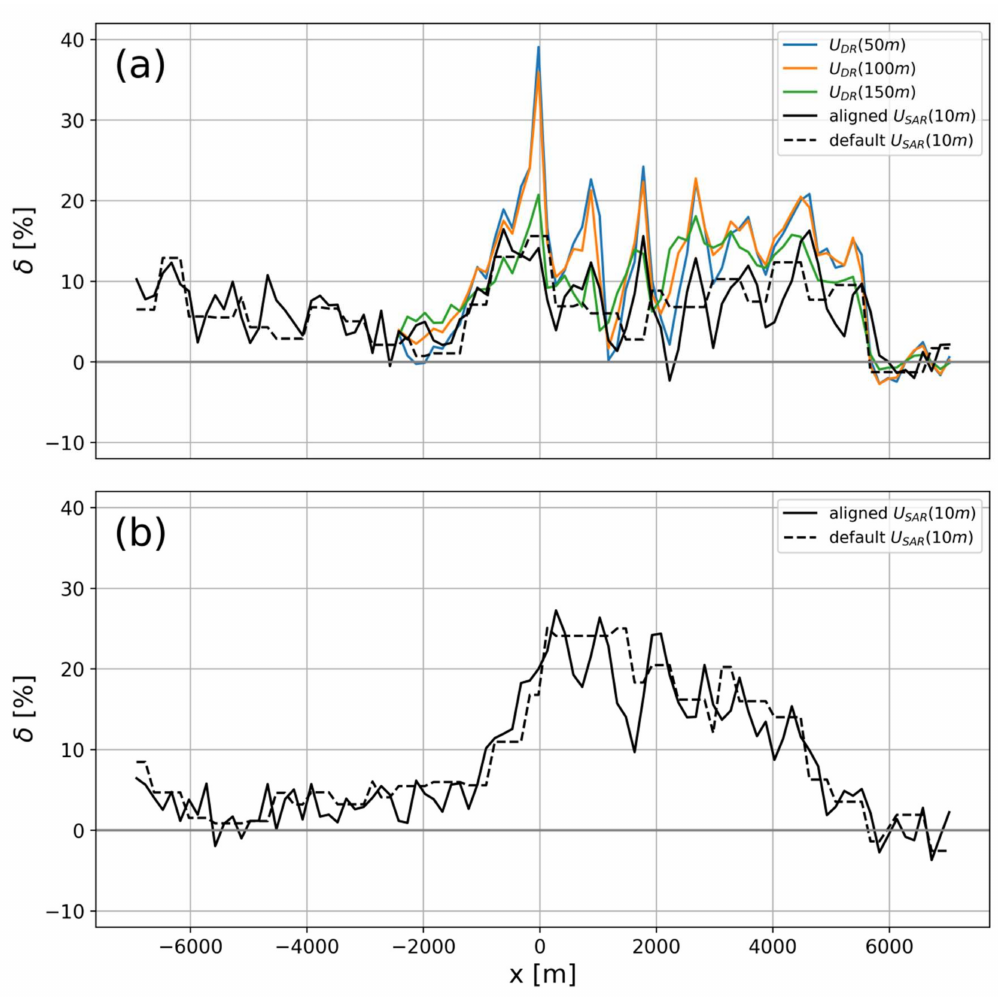
Figure 11. Transects of the velocity deficit for Case 3 at ( a ) 700 m and ( b ) 3700 m downstream. x is defined as the cross-wind distance to turbine location